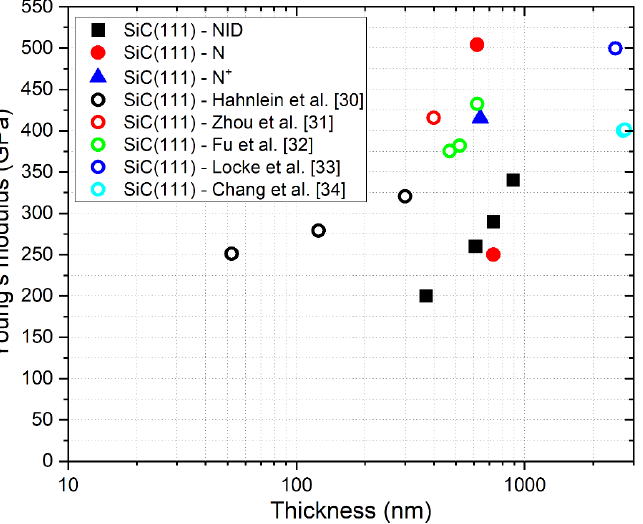
Figure 16. Comparison of measured values of E with other results from the literature about 3C-SiC grown on <111> silicon.